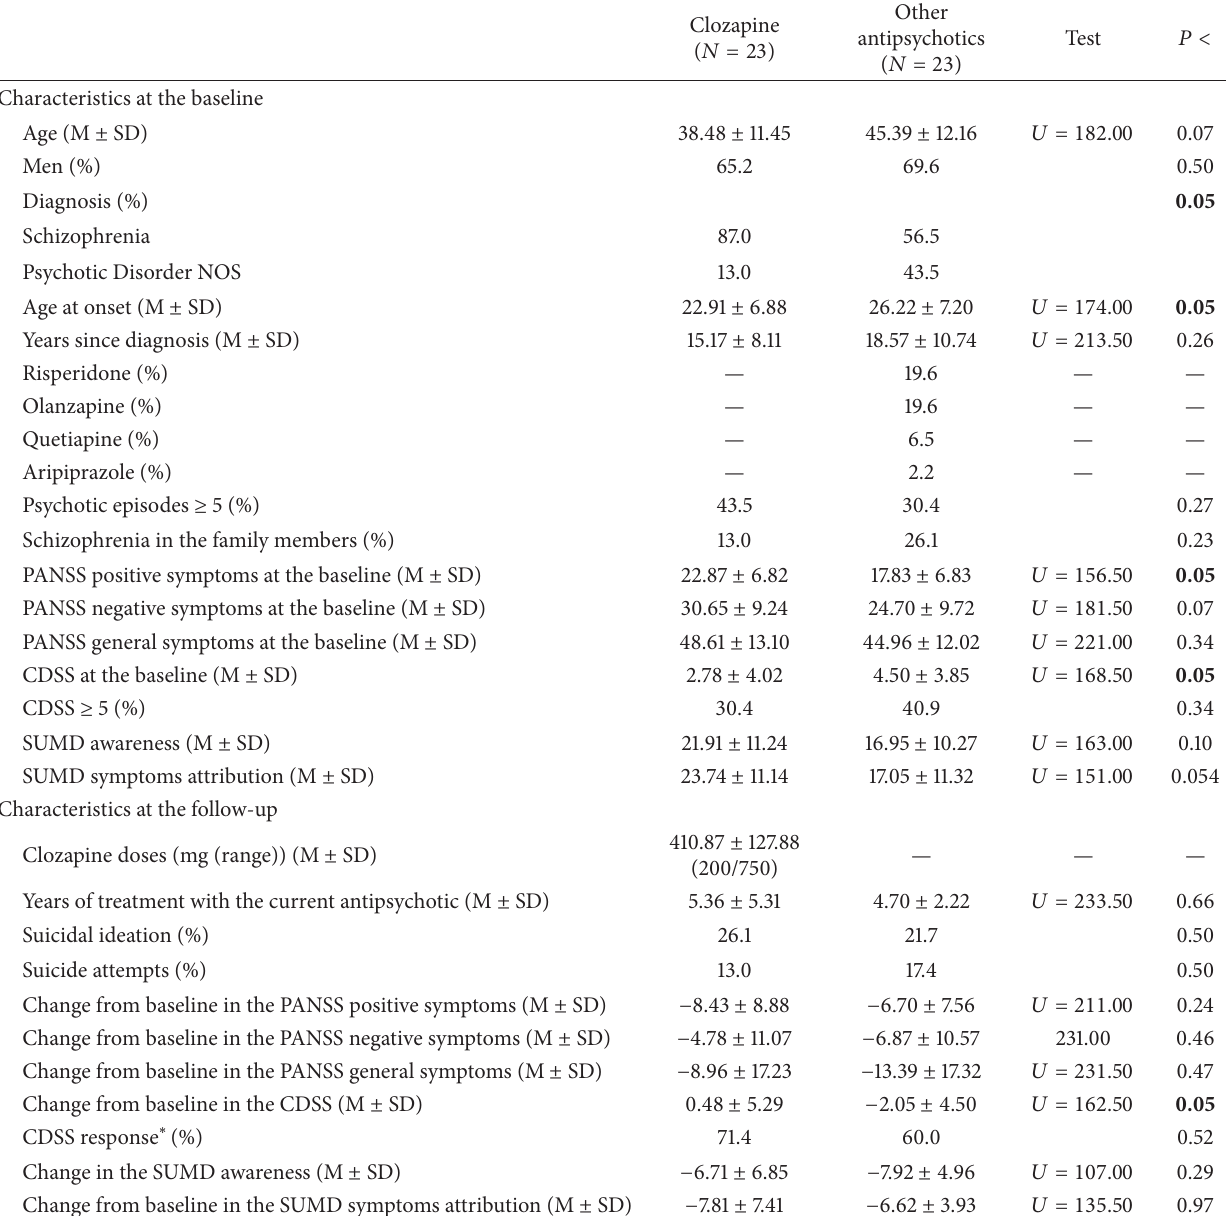
Table 1: Differences between